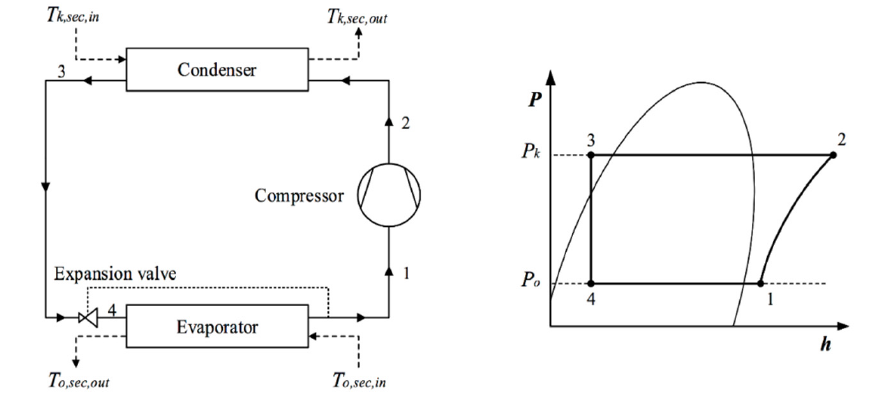
Figure 1. Vapour compression HTHP and Ph Diagram.